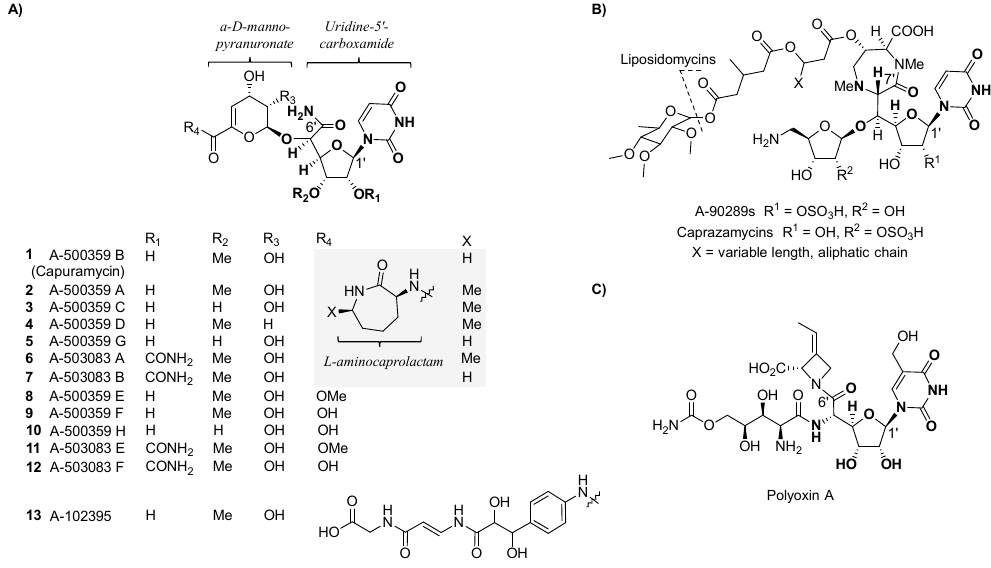
Figure 2. Structures of high-carbon sugar nucleosides. ( A ) Structure of the three major groups (A-500359s, A-503083s, and A-102395) of capuramycin-type nucleoside antibiotics isolated from different bacterial strains. ( B ) Structure of representative 5’- C -glycyluridine (GlyU)-containing nucleoside antibiotics. ( C ) Structure of the antifungal compound polyoxin A.